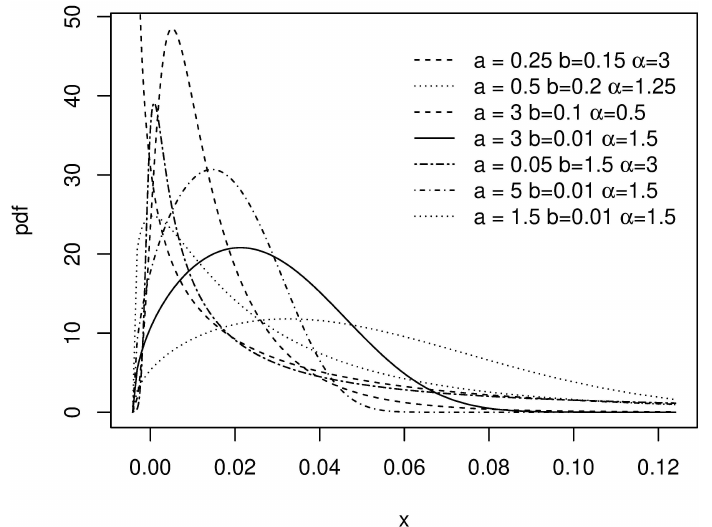
Figure 1. Curves of the pdf of the NHLx distribution for various parameter values, but with the fixed value: β =